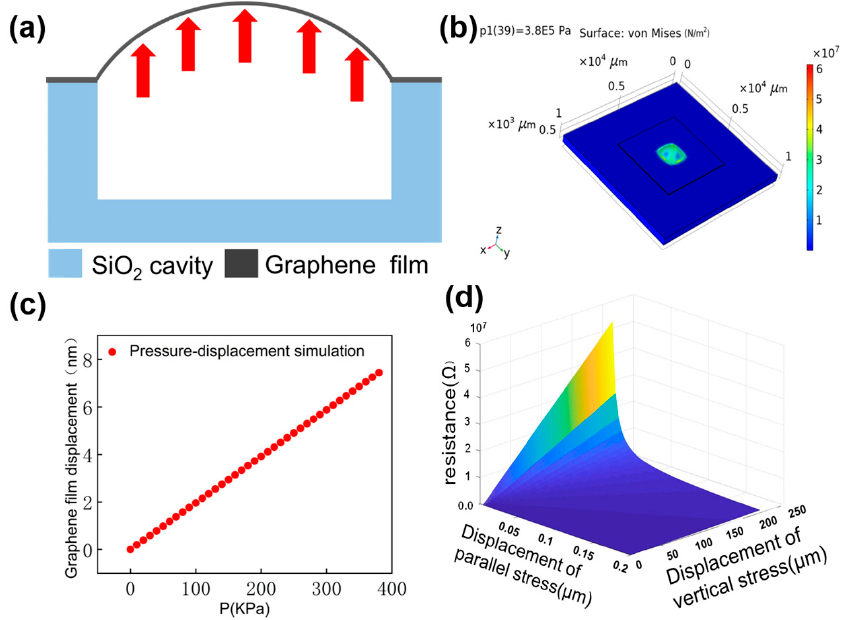
Figure 2. ( a ) Principle of signal conversion of sensor sensitive unit The arrows show the expansion of the film when heated. ( b ) Displacement of monolayer graphene with PMMA at 385 kPa. ( c ) Graphene film Pressure-displacement simulation results in COMSOL. ( d ) Simulation of the piezoresistive effect for predicting graphene resistance changes in MATLAB